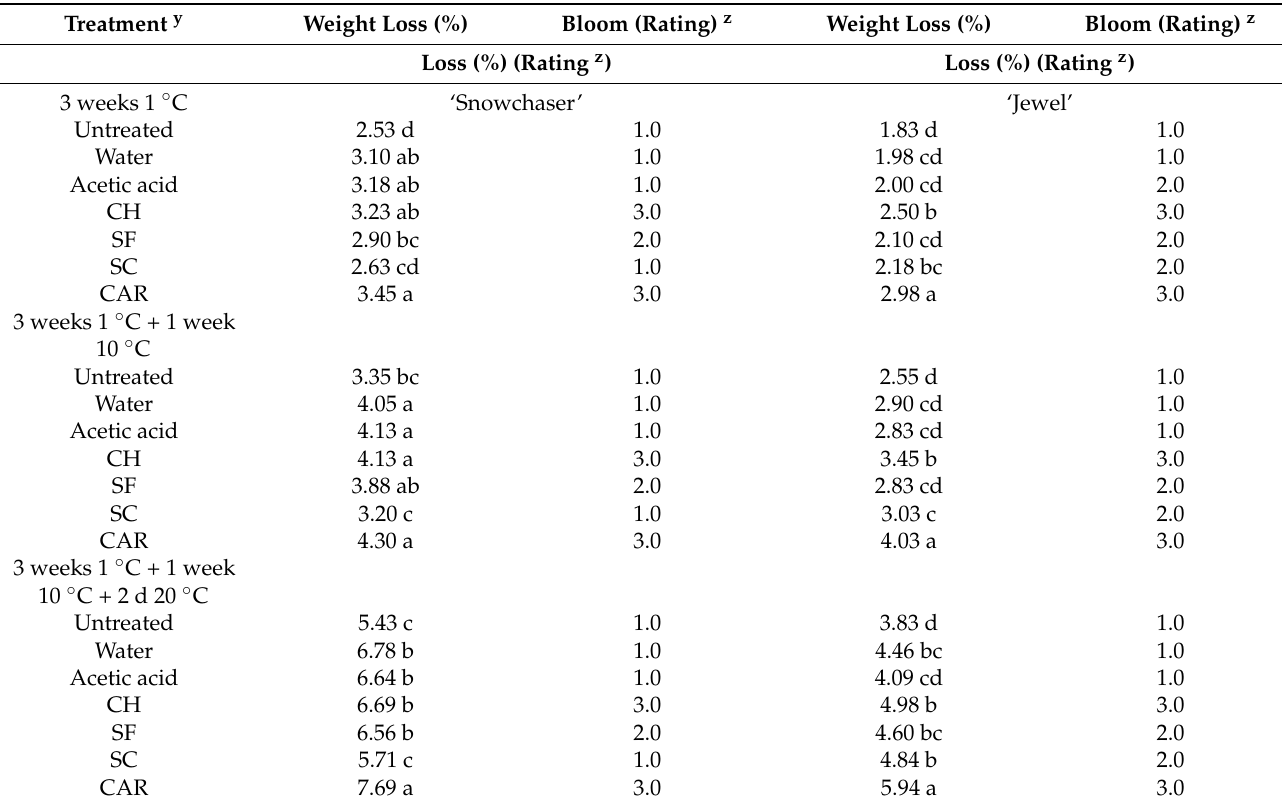
Table 2. Influence of dip coatings on weight loss and berry bloom rating following simulated storage and marketing in season